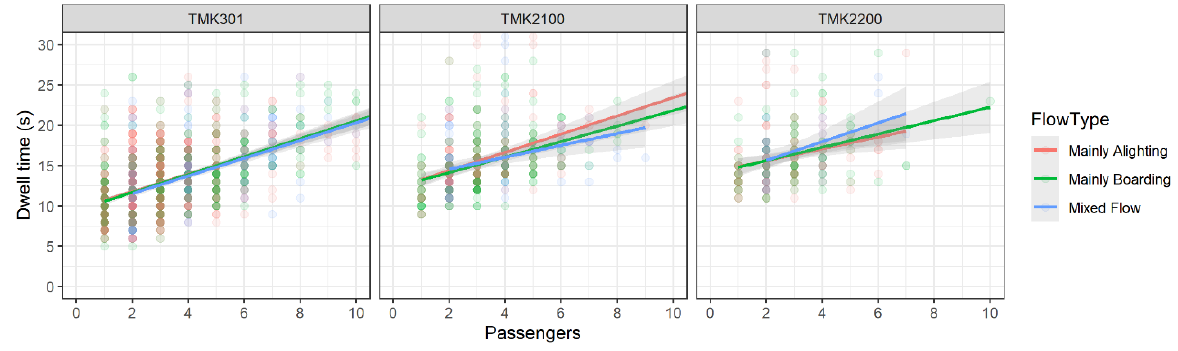
Figure 14. Dependence of dwell time on the type of passenger flow on the busiest tram